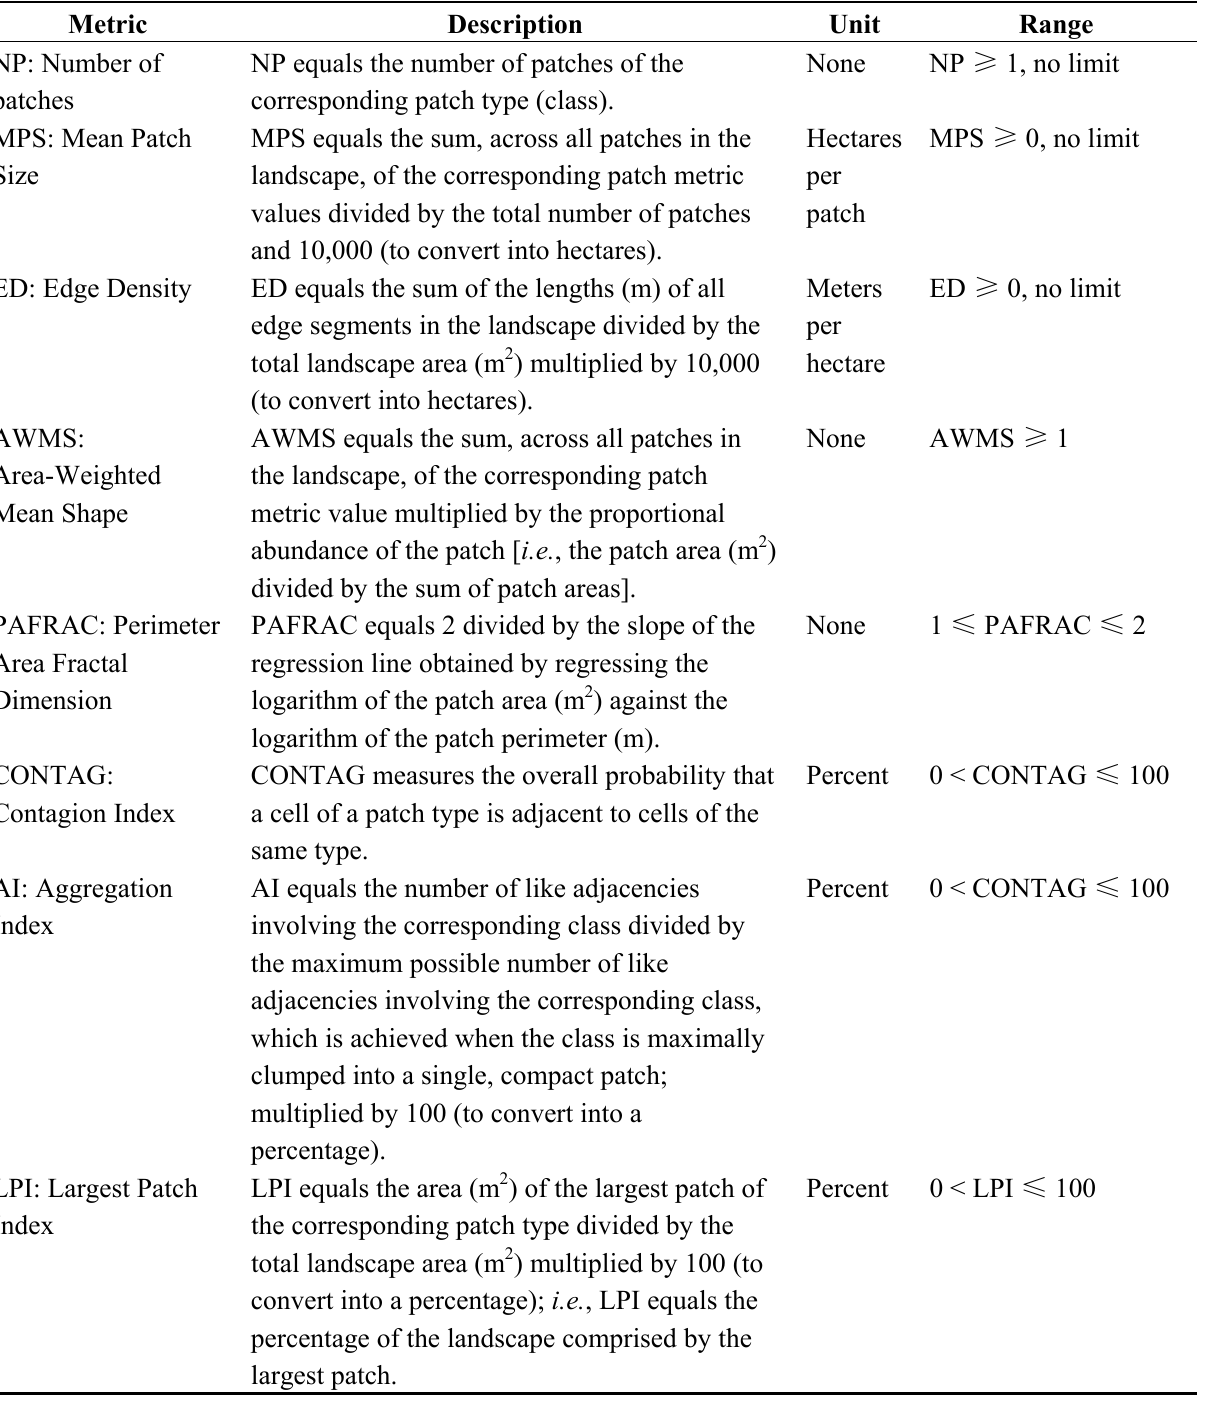
Table 2. Landscape metrics used in this